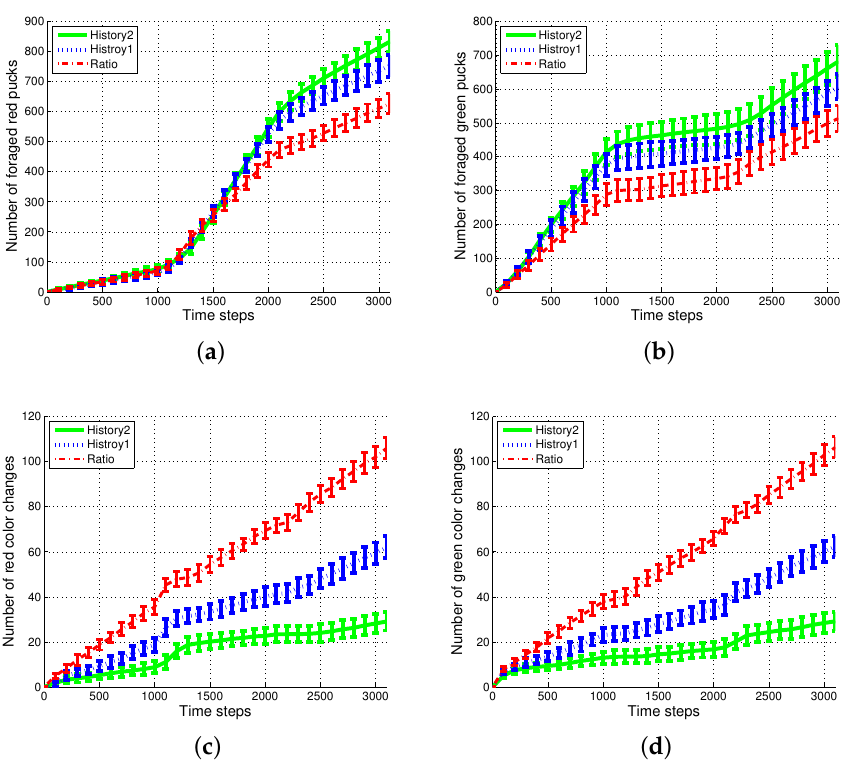
Figure 3. Number of foraged ( a ) red and ( b ) green pucks and occurrences of task switching in foraging for ( c ) red and ( d ) green